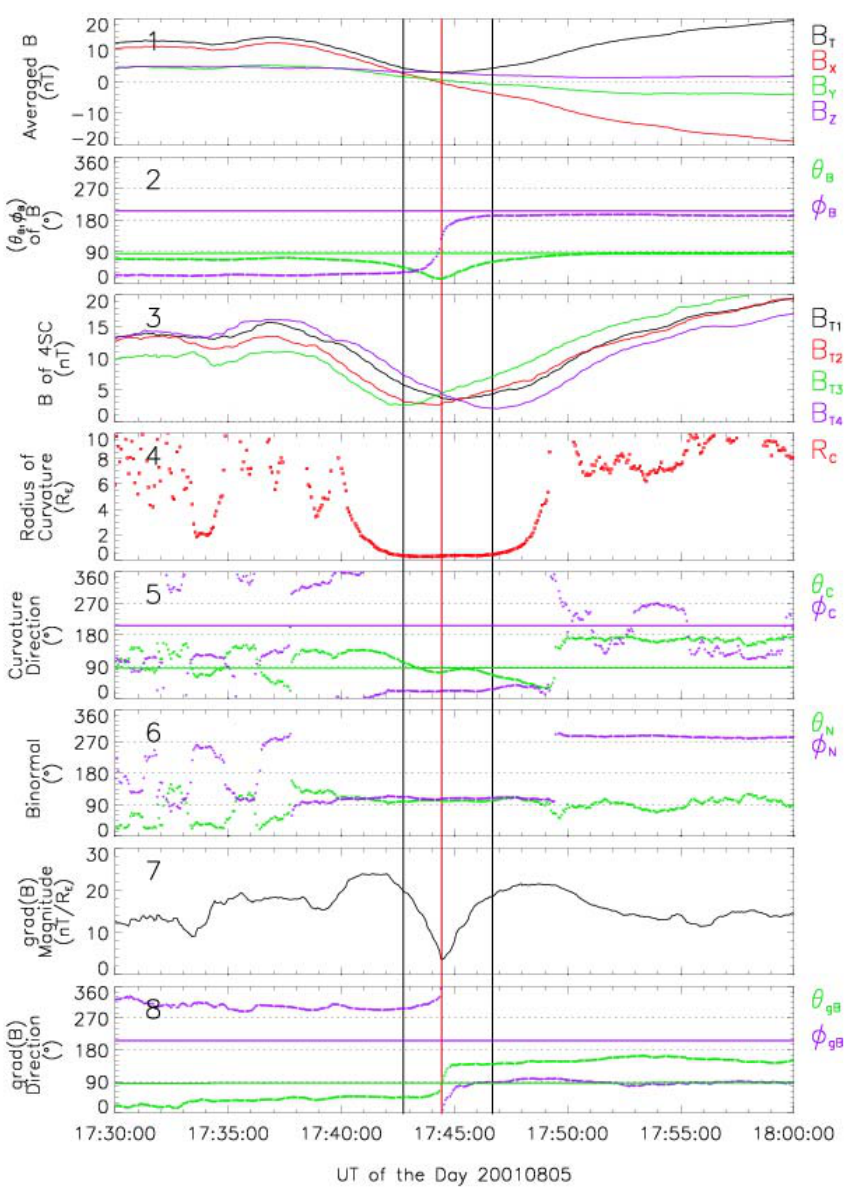
Fig. 1a. The geometric structure of the tilted current sheet during one Cluster crossing event on 5 August 2001. Panel 1: the magnetic field at the center of Cluster tetrahedron as are the average of those at the four spacecraft; panel 2: the directional angle ( θ B , ϕ B ) of the magnetic field at the center of Cluster tetrahedron; panel 3: magnetic strengths observed by the 4 spacecraft of Cluster; panel 4: the radius of curvature R c ; panel 5: the direction angles ( θ c , ϕ c ) of the curvature of the MFLs, that is also the direction angles of the principal normal; panel 6: the direction angles ( θ N , ϕ N ) of the normal of the osculating plane, or the binormal, of the MFLs; panel 7: the value of the gradient of magnetic field strength; panel 8: the directional angle ( θ gB , ϕ gB ) of the gradient of magnetic field strength. GSM coordinates are used here. The polar angle and azimuthal angle of the position vector of Cluster in GSM are also plotted in the panel of ∇ B/B direction as green and violet horizontal lines,